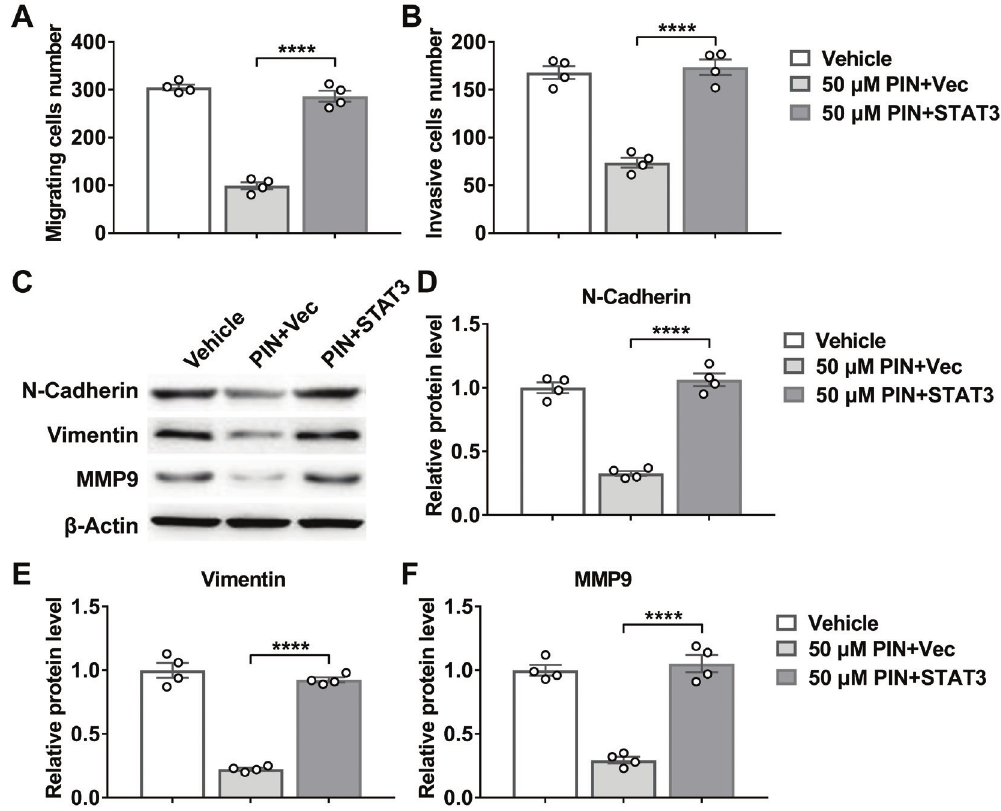
Fig. 5. Overexpression of STAT3 reversed the effect of PIN on A549 cells. A549 cells were transfected with vector or plasmid coding STAT3 and treated with 50 μM pinocembrin (PIN). Cell migration (A) and invasion (B) were analyzed. And the protein levels of N-Cadherin (C and D), Vimentin (C and E) and MMP9 (C and F) were determined by western blot. Four wells per group. The significant difference was analyzed using one-way ANOVA test. **** P <